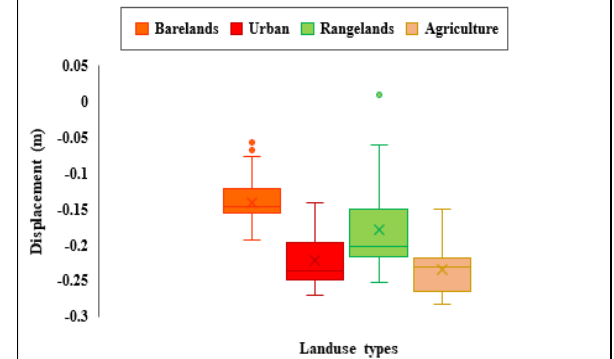
Figure 4. Box and Whisker plot for the variation of random points in the deformational areas according to the four selected land use types; Bare lands, Urban areas, Rangelands, and Agricultural